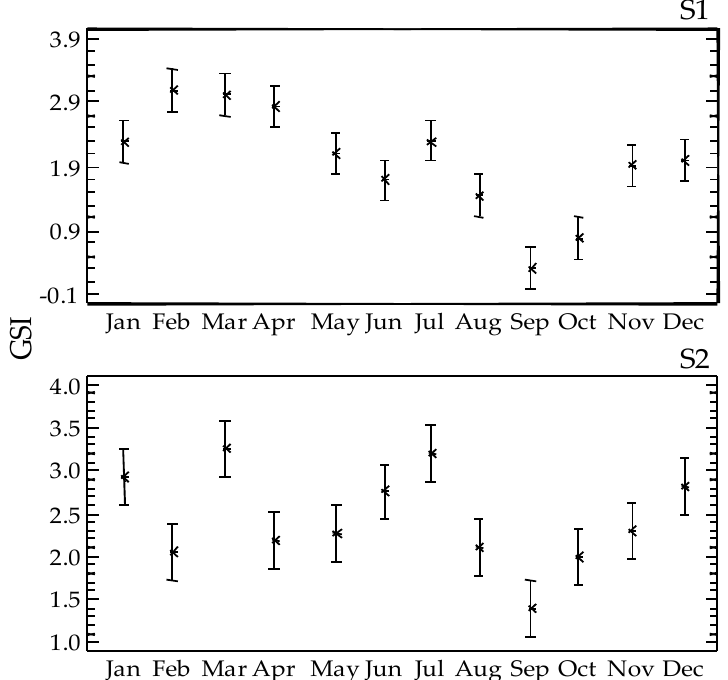
Figure 5. Temporal trend of the mean gonad-somatic index GSI ± Fisher LSD of Sphaerechinus granularis at the two sampling stations (S1, S2) in Pagasitikos Gulf.